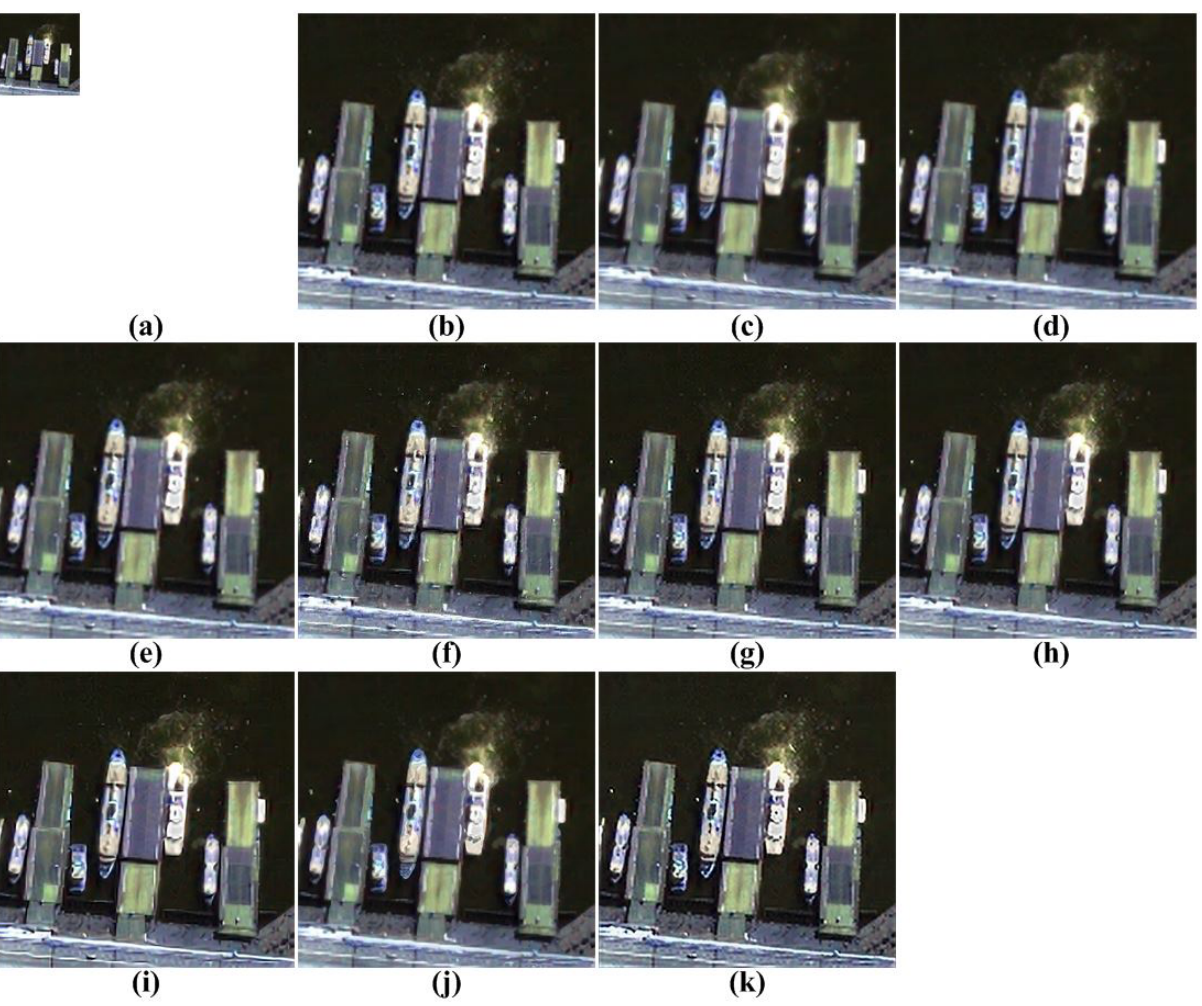
Figure 15. Results of resolution enhancement by enlarging a real UAV image: ( a ) original HR image in Figure 11d; result of: ( b ) cubic-spline interpolation [3]; ( c ) interpolation-based SR [4]; ( d ) interpolation-based SR [5]; ( e ) interpolation-based SR [6]; ( f ) example-based SR [7]; ( g ) patch-based SR [9]; ( h ) patch-based SR [10]; ( i ) patch-based SR [11]; ( j ) patch-based SR [12] and ( k ) the proposed